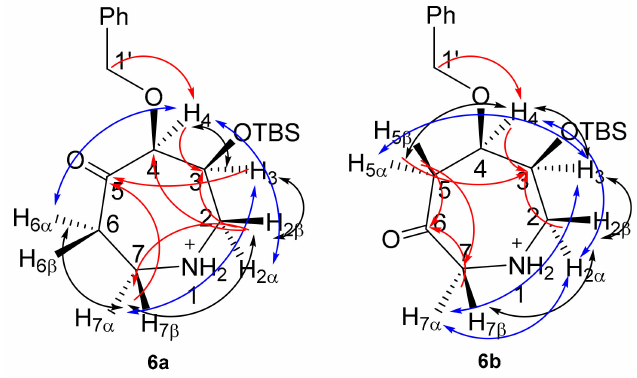
Figure 4. 2D-NMR correlations for monohydroxyl azepanes 6a and 6b . Red, HMBC; black, COSY; blue,